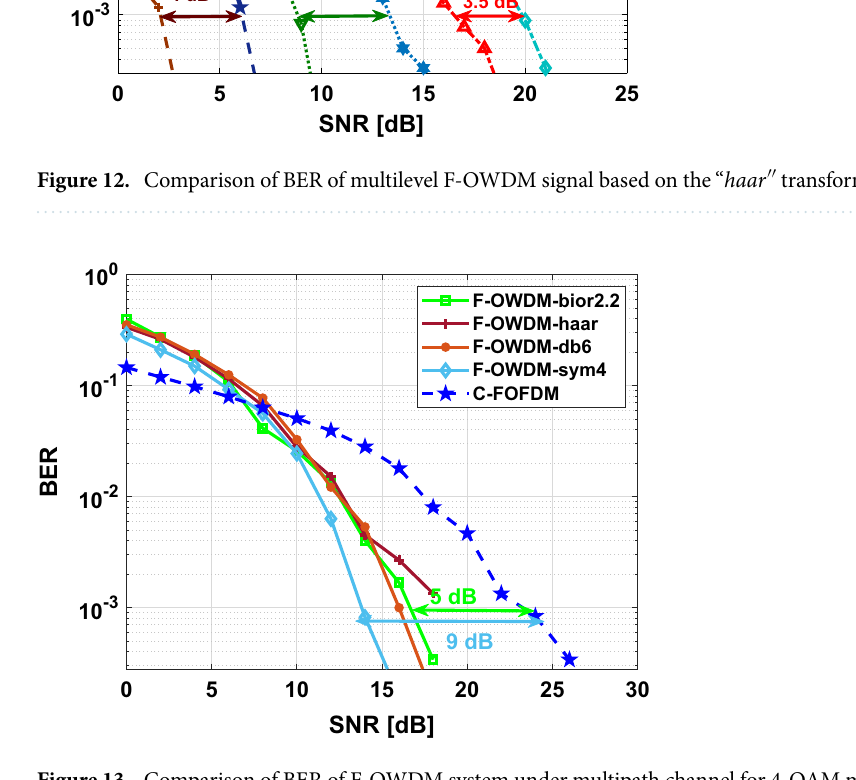
Figure 13. Comparison of BER of F-OWDM system under multipath channel for 4-QAM